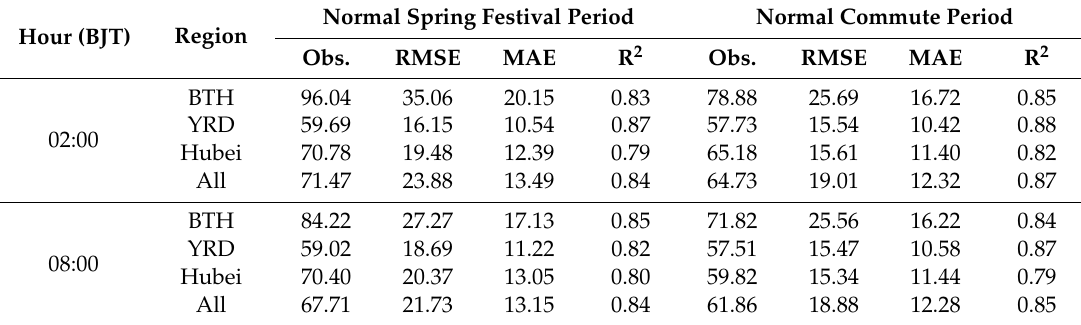
Table 3. The average prediction accuracy of 10-fold cross validation experiments of STRF models in di ff erent